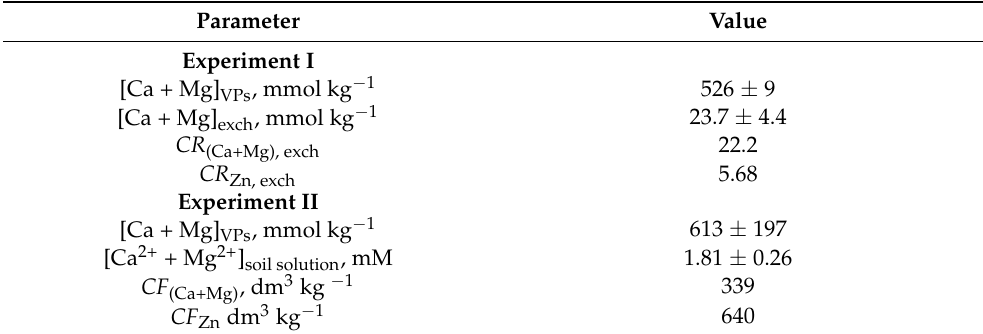
Table 2. The determined values of the parameters used to calculate PBC(V) Zn (according to experi- ments 1 and